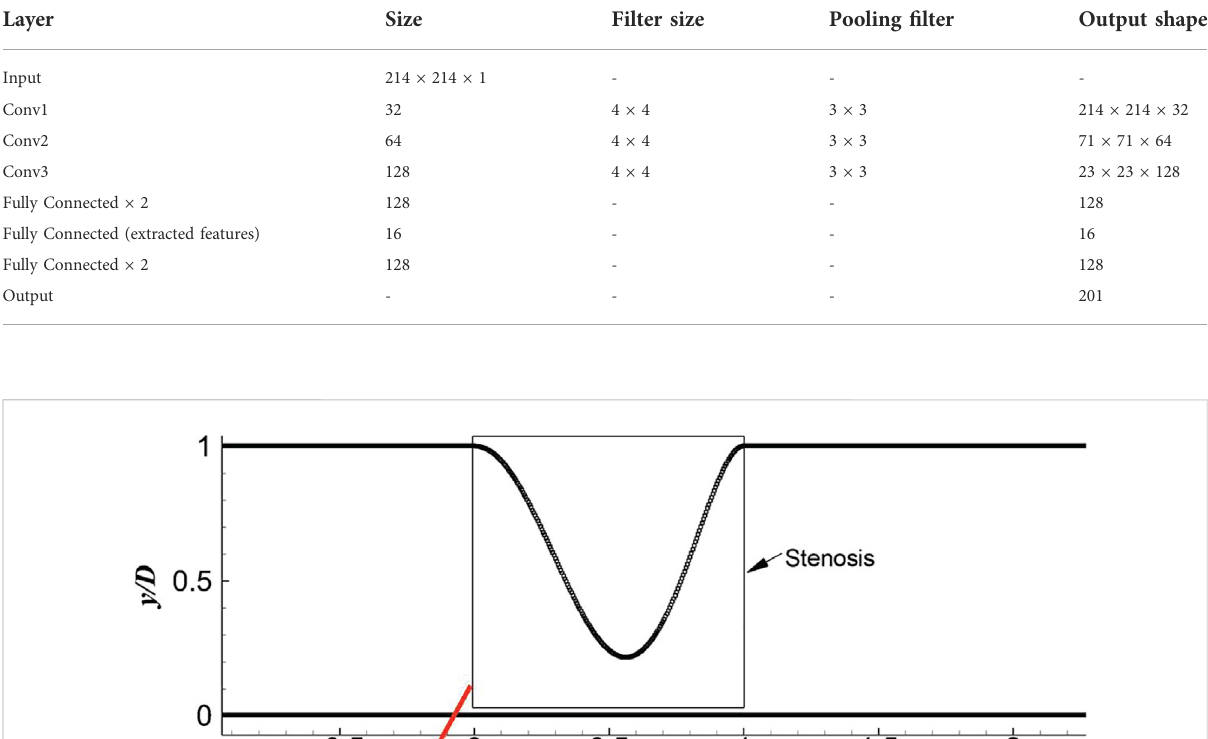
TABLE 1 Details of the 2D CNN.